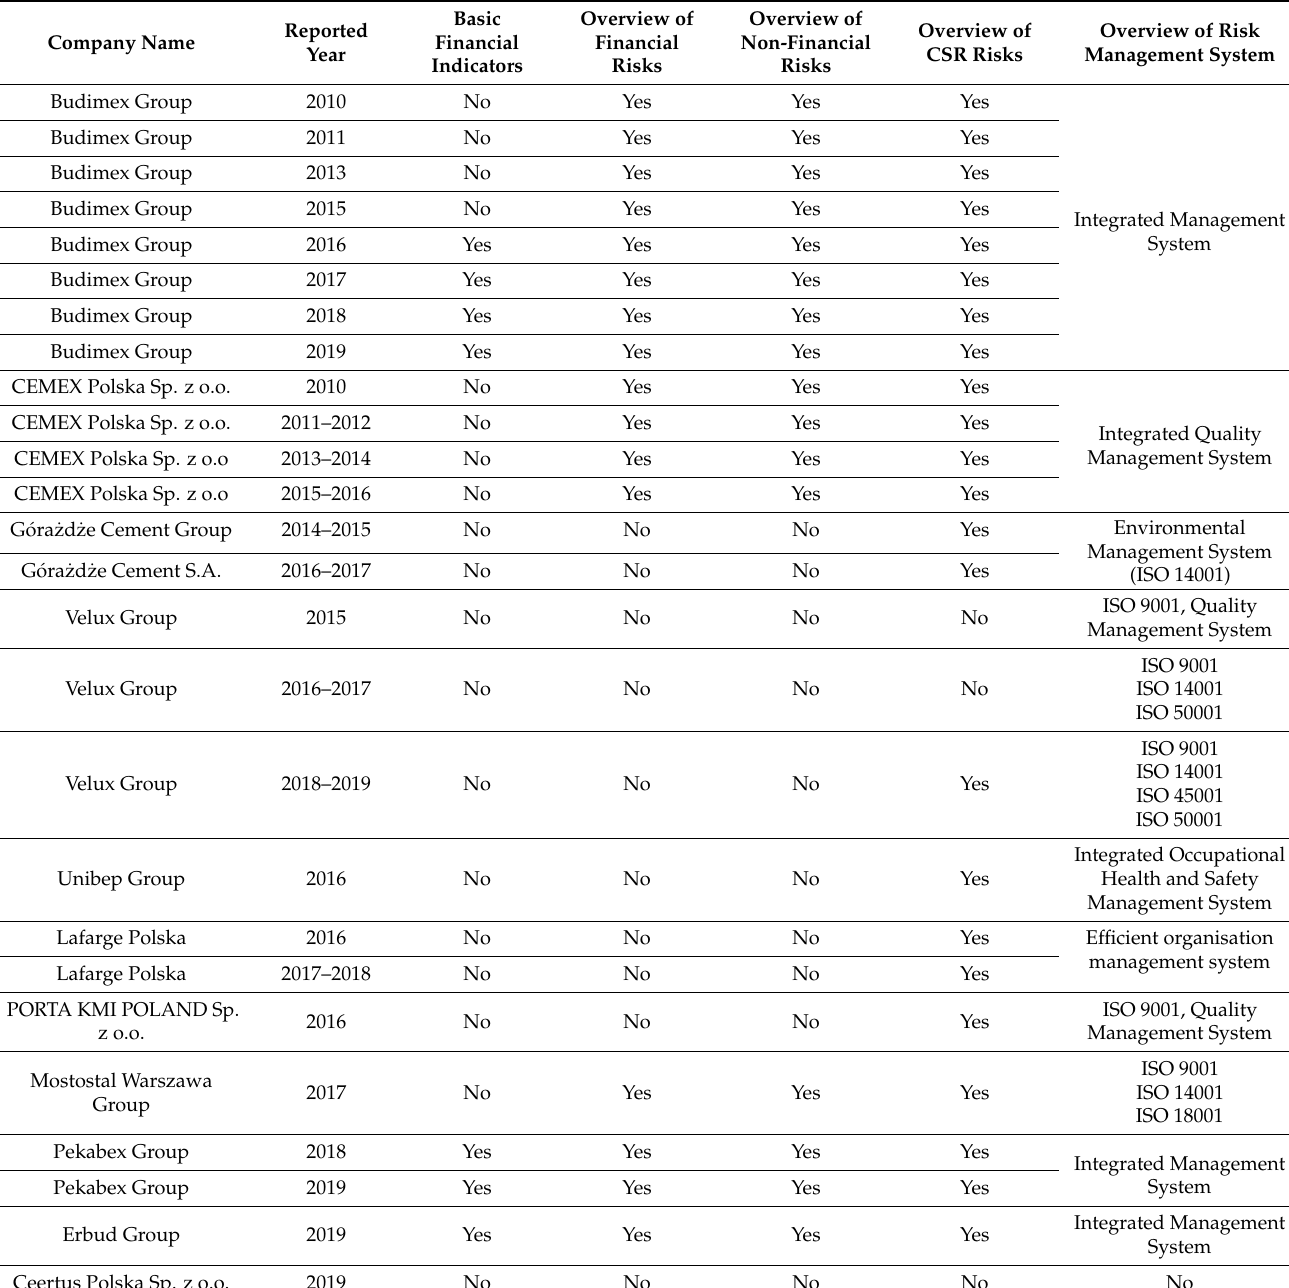
Table 4. Data on financial condition and risks in the analysed CSR and integrated